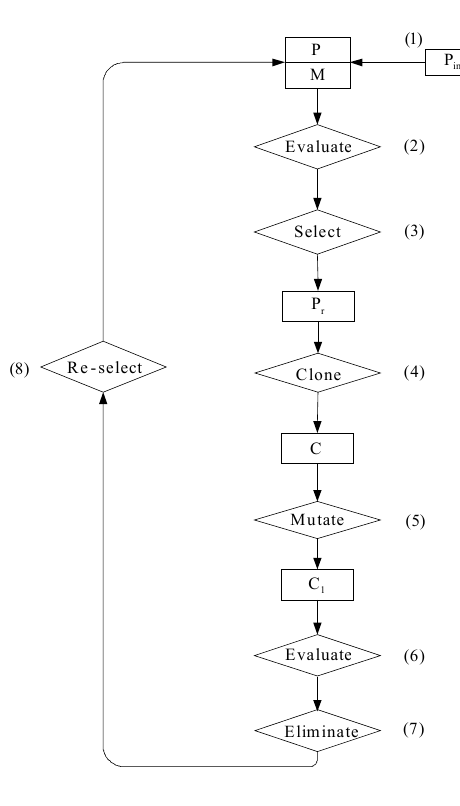
Fig. 1. Flow chart of basic